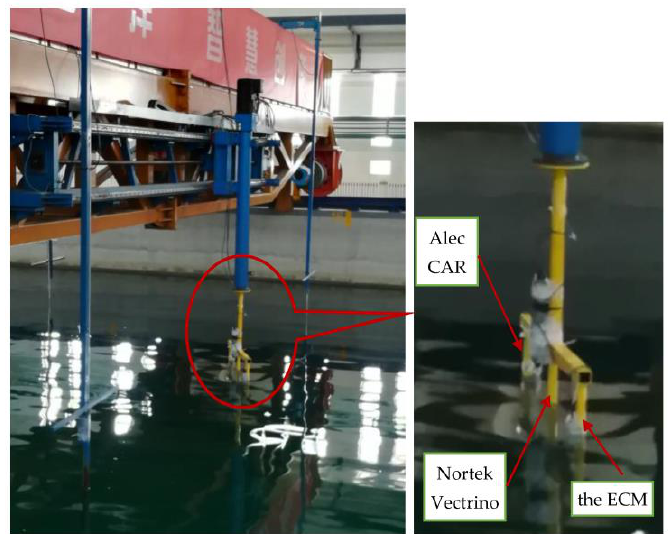
Figure 12. Indoor driving comparison test. Table 2. Repeatability test of indoor running velocity